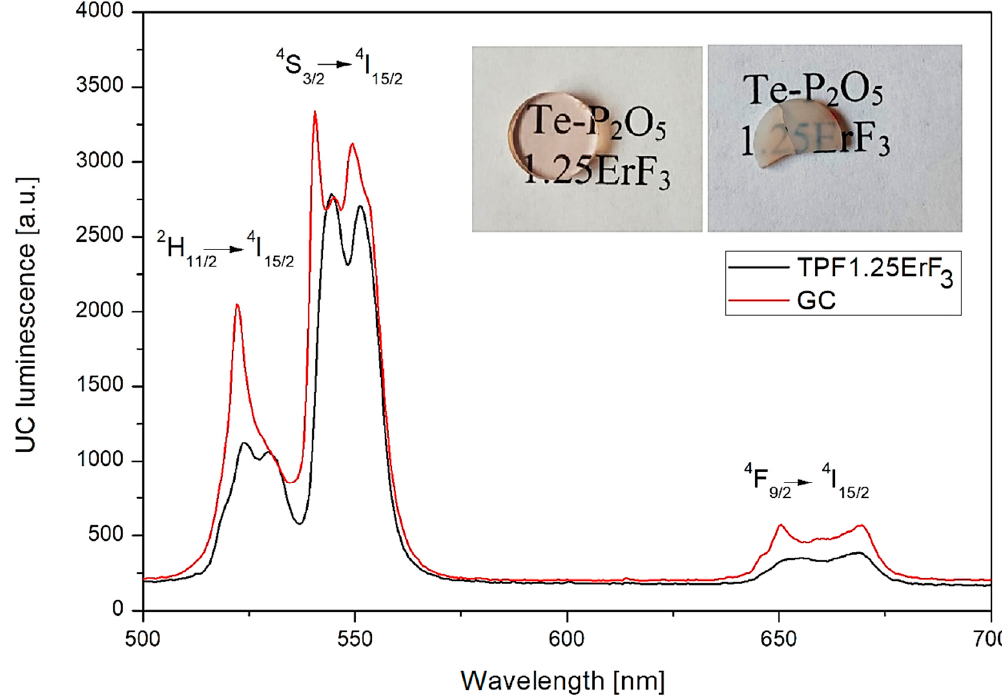
Figure 21. Upconversion emission of TP1.25ErF 3 glass and glass-ceramic. (inset) Image of fabricated glass and